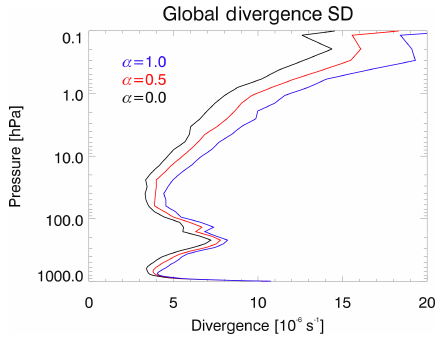
Figure 17. Vertical profiles of the global standard deviation of the divergence (s − 1 ) for ozone assimilation experiments on 1 Decem- ber 2014 (00:00Z). Lines are α = 0 . 0 (black), α = 0 . 5 (red), and α = 1 . 0 (blue). See Table 1, Sect.